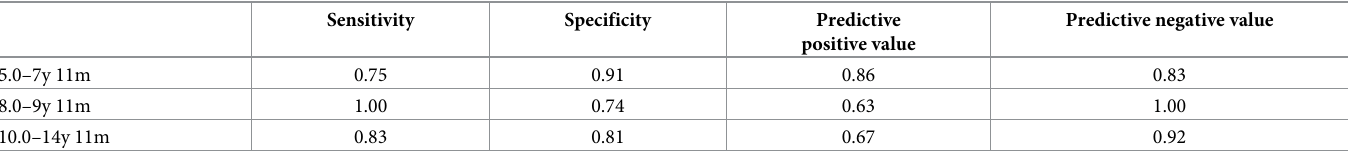
Table 4. Sensitivity, specificity of the DCDQ-FE using a cut-off at 56.